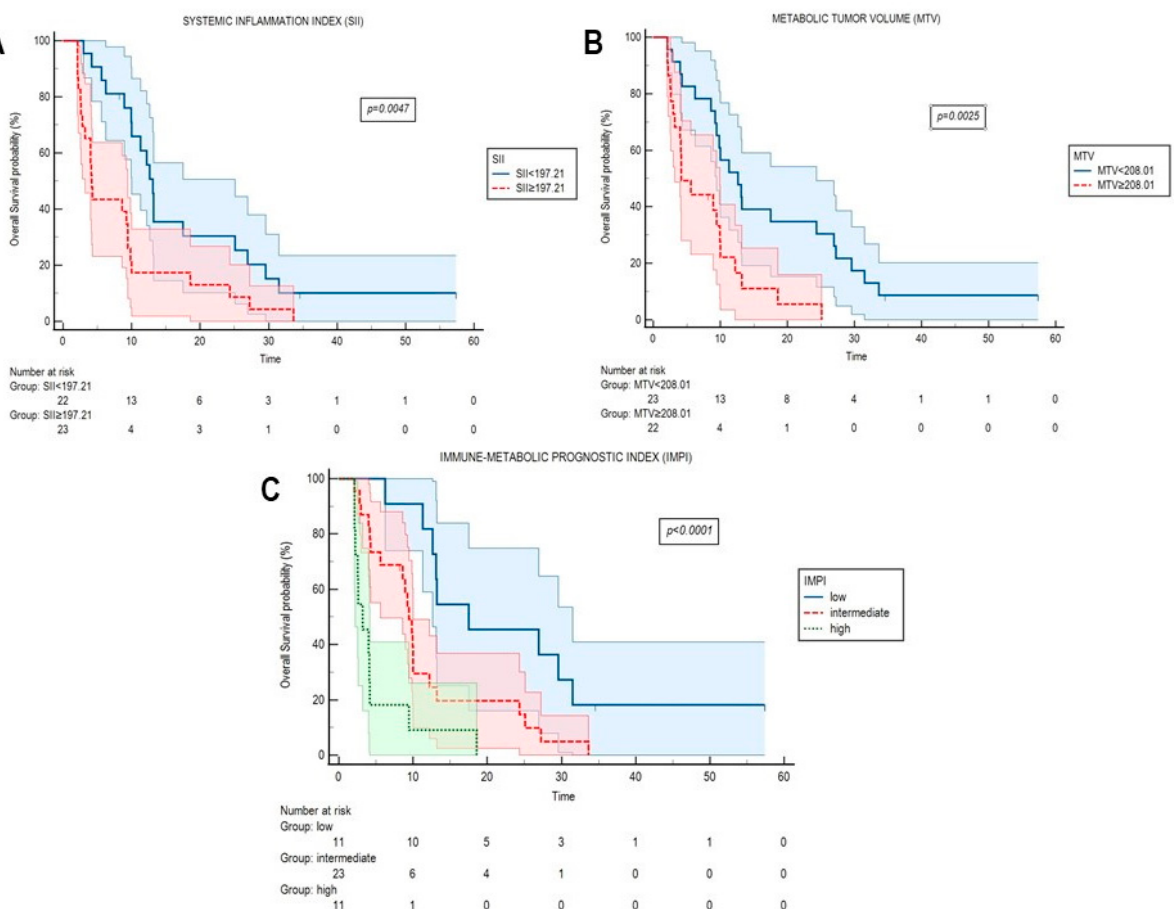
Figure 2. Kaplan–Meier curves for OS according to systemic inflammatory indexes, FDG-derived parameters, and their combination (IMPI) at the time of radiological progression. Kaplan–Meier curves for overall survival (OS) according to systemic inflammation index (SII, ( A )), metabolic tumor volume (MTV, ( B )), and their combination in the immune-metabolic prognostic index (IMPI, ( C )). SII, MTV and IMPI were calculated at the time of radiological progression.